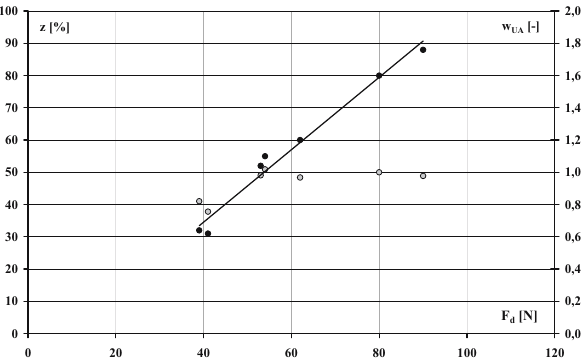
Figure 5: Dependence of the braking e ffi ciency index ( z , black color ) and a proportion ratio between the braking rate and the pressure on the brake pedal ( w UH , color gray ) on the force on the handbrake ( F p ) .